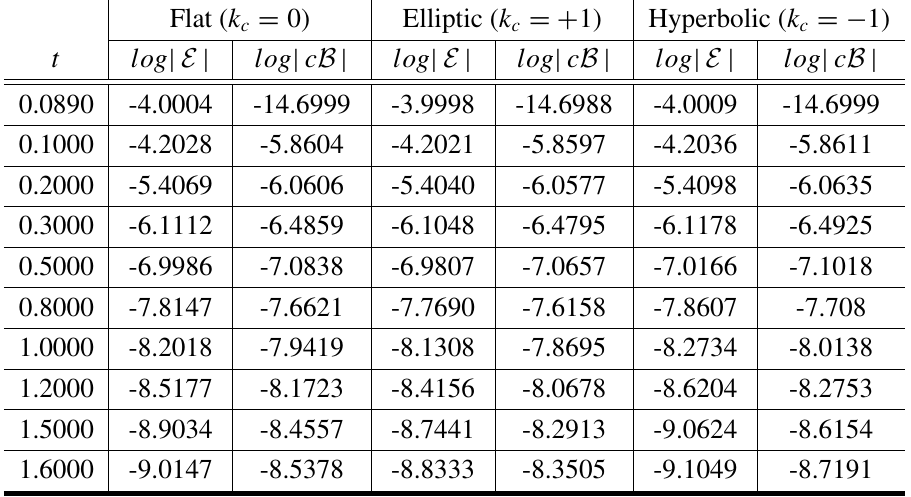
Some Results of the Numerical